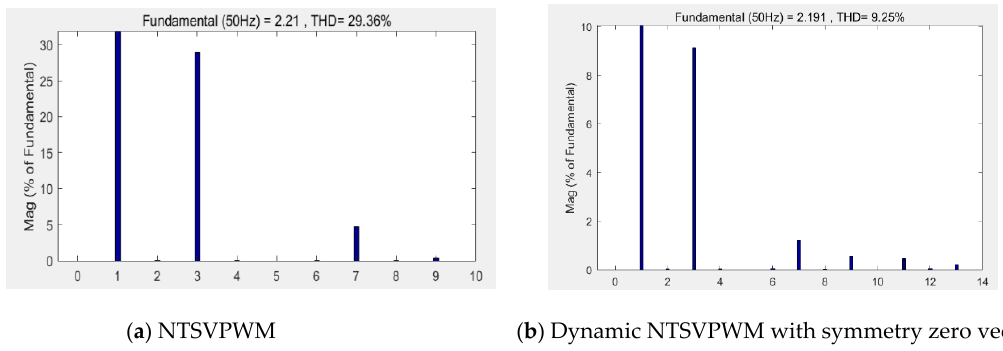
Figure 18. Harmonic characteristics at m = 1.1.